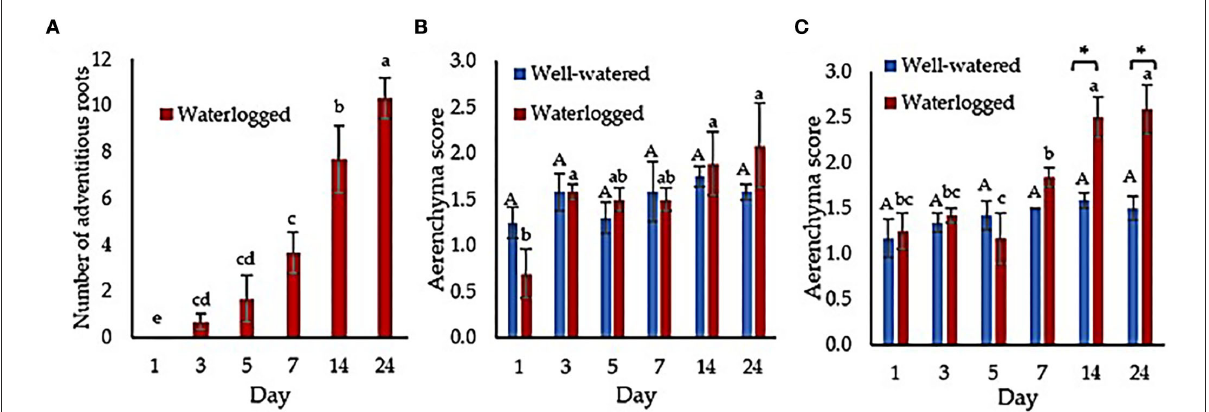
FIGURE2 Adventitious root and aerenchyma formation. (A) The number of adventitious roots in well-watered and waterlogged banana plants. The mean aerenchyma score of (B) 5cm from the root tip and (C) 5cm from the root base. The results represent the mean ± standard error of the mean of nine independent biological replicates with three technical replicates each. Different capital letters indicate a significant difference between time points within well-watered samples. Different lowercase letters indicate a significant difference between time points within waterlogged samples. Asterisk (*) indicates a significant difference between well-watered and waterlogged samples at the same time point ( p < 0.05). Adapted from Teoh et al.